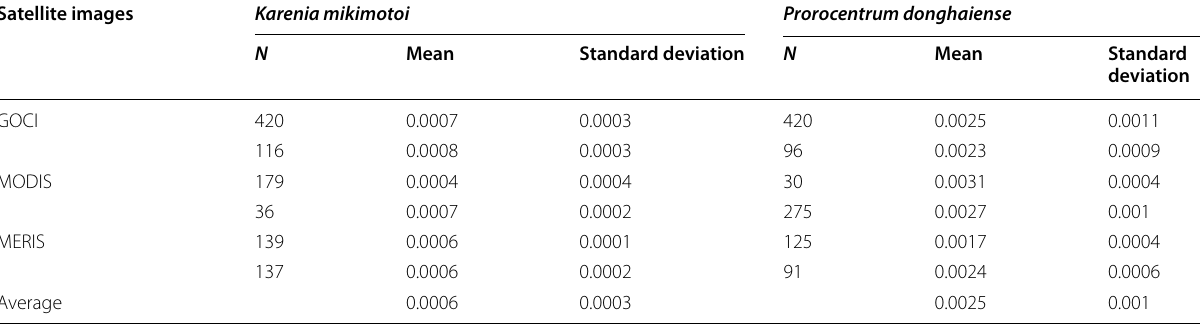
N in the table refer to the pixle numbers in each bloom region